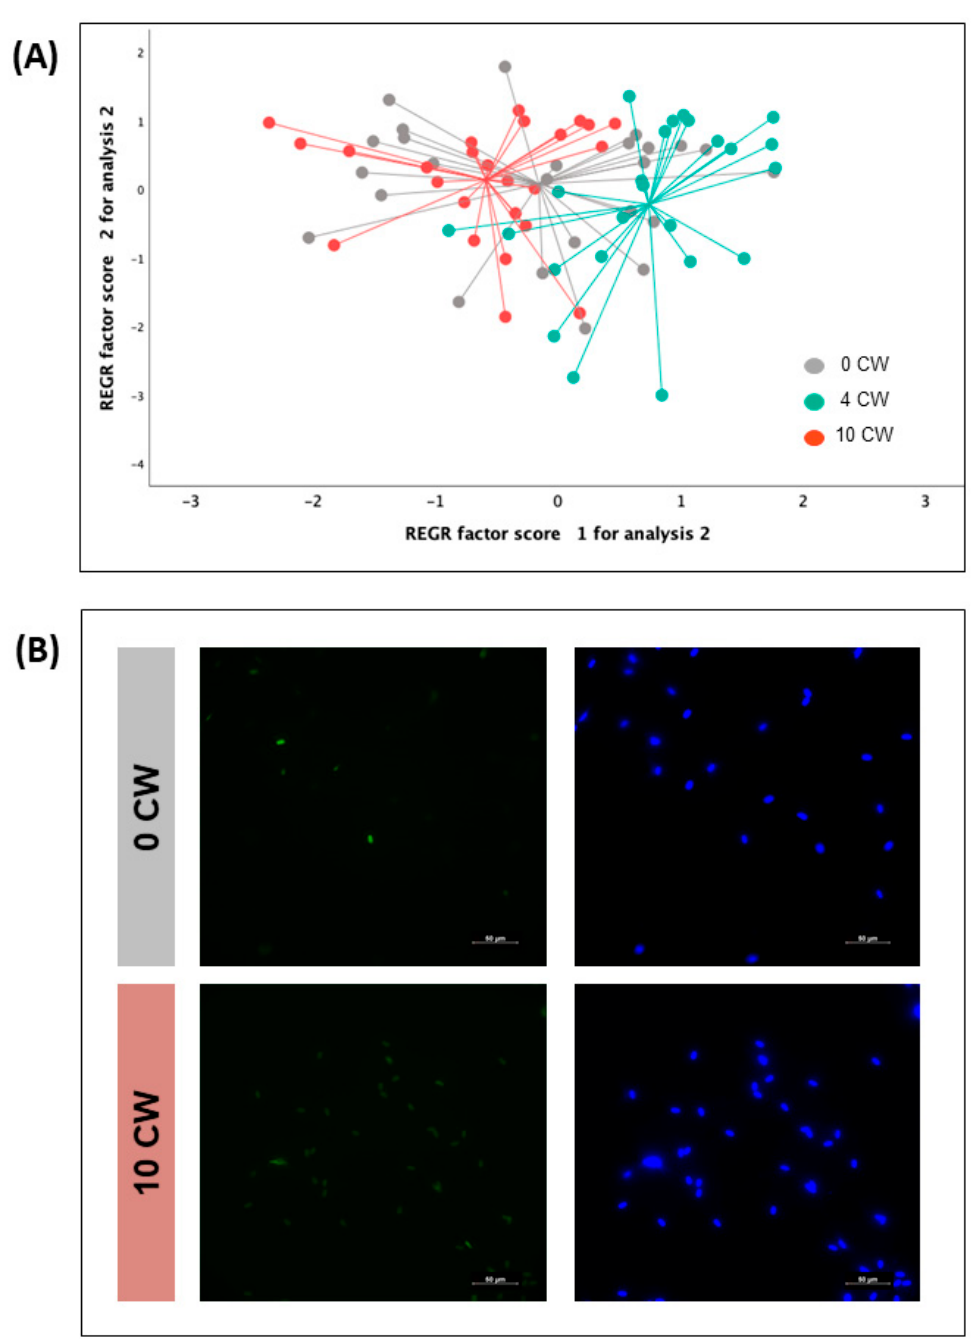
Figure A1. ( A ) Representation of twenty-five rams in frozen-thawed samples: scatter plot of males depending on the sperm collection frequency (zero sperm collection per week (0 CW), 4 collections per week (4 CW), 10 collections per week (10 CW) separated by the two principal components obtained by principal component analysis (PCA) to reduce the dimensionality of the dataset. ( B ) Ram sperm confocal images of frozen-thawed samples: apoptosis marker (CellEvent Caspase-3/7 Green) and nuclear marker (Hoechst) in zero sperm collection per week (0 CW) and 10 sperm collections per week (10 CW).